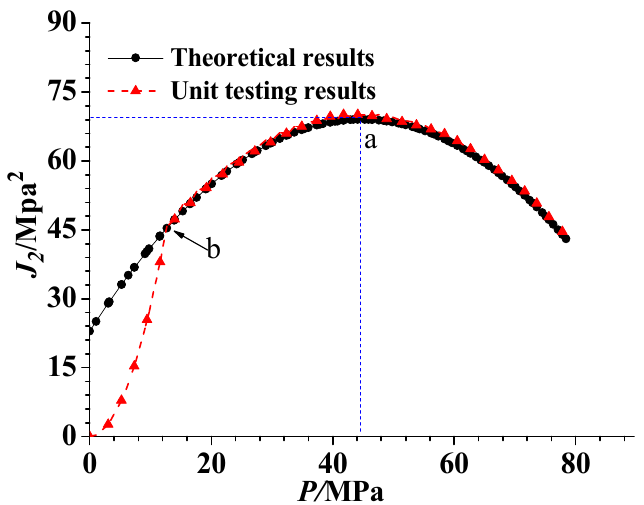
Figure 15. Comparison of J 2 − p relationship between theoretical results and unit testing re- sults.